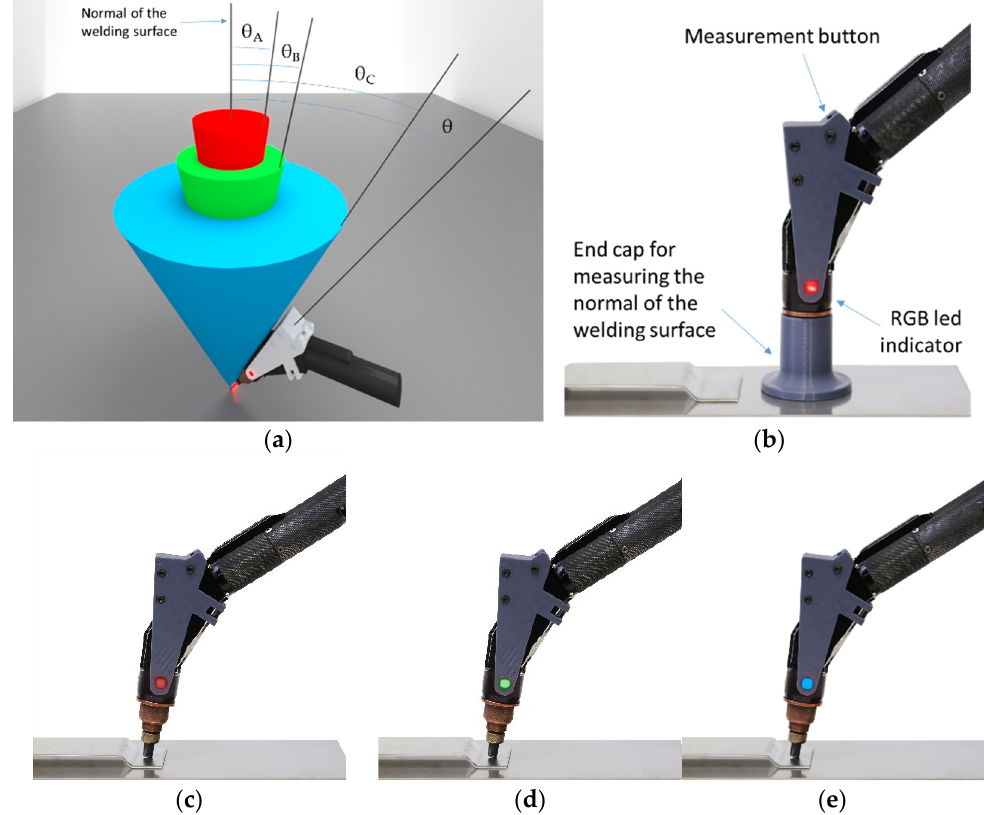
Figure 8. Using the smart welding torch. ( a ) Representation of the critical laser holding angles. ( b ) Measurement of the normal of the welding surface by the operator. ( c ) Excessively vertical holding angle, 0 < θ < θ A . ( d ) Appropriate holding angle, θ A < θ < θ B . ( e ) Excessively inclined holding angle, θ B < θ < θ C